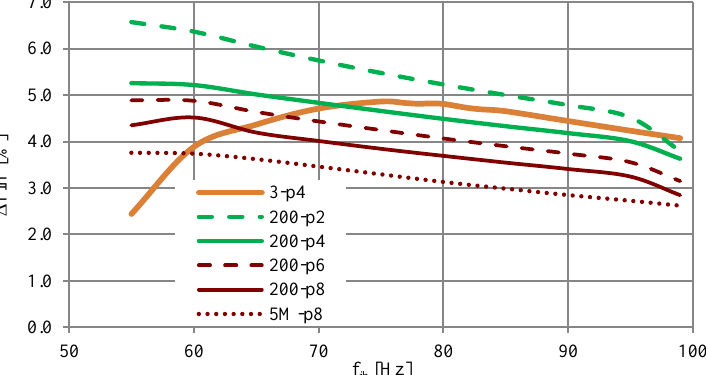
Figure 12. Computed amplitude of torque pulsations Δ T ih vs. the frequency of voltage interharmonics for the various motors and the case of CRS.